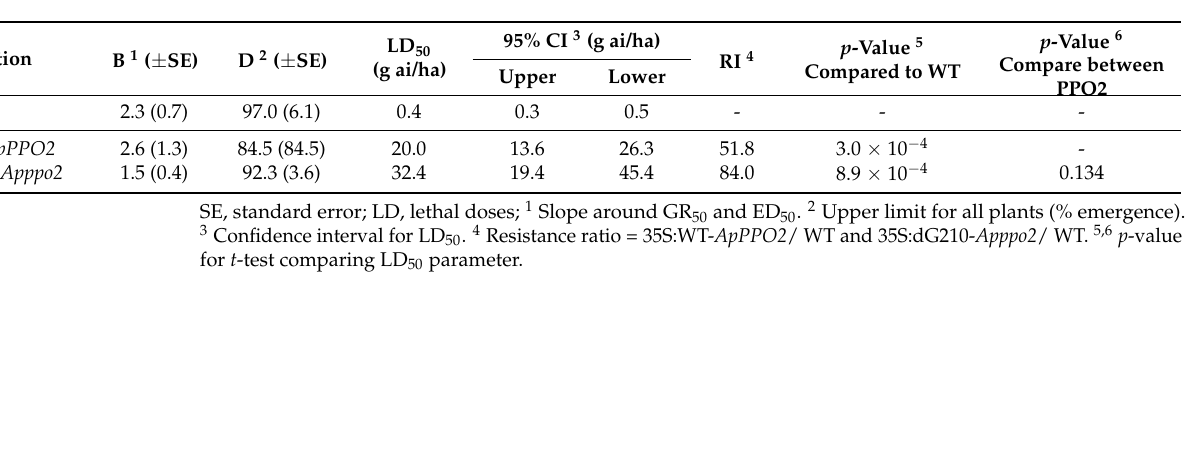
Table 3. Parameters estimate of the dose–response curve used to calculate the herbicide dose required for decrease the 50% emergence (LD 50 ) of each Arabidopsis line evaluated three weeks after the